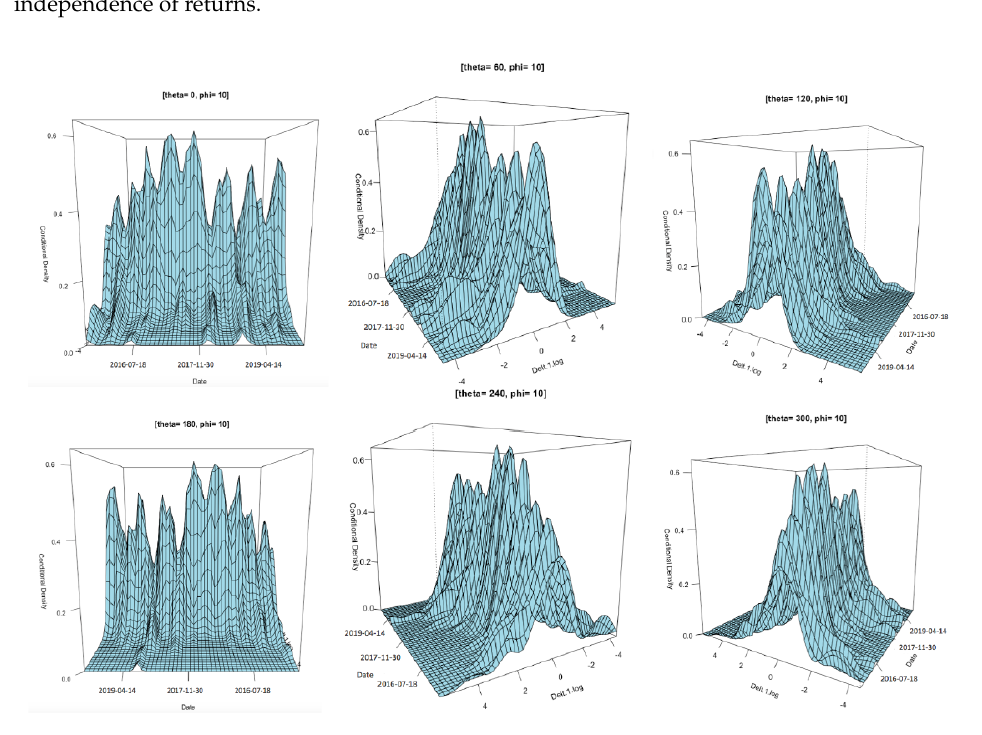
Figure 2. Density of NASDAQ: